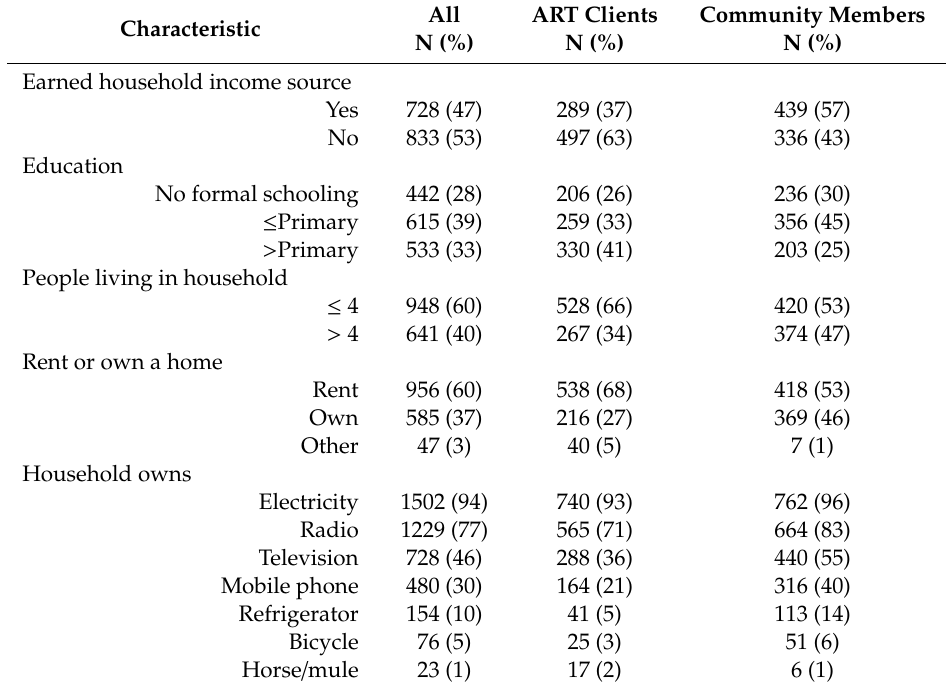
Table 1. Demographic and household characteristics of respondents, N 1 (%), of antiretroviral therapy (ART) clients ( n = 795) and community members ( n = 795), Ethiopia, 2008.